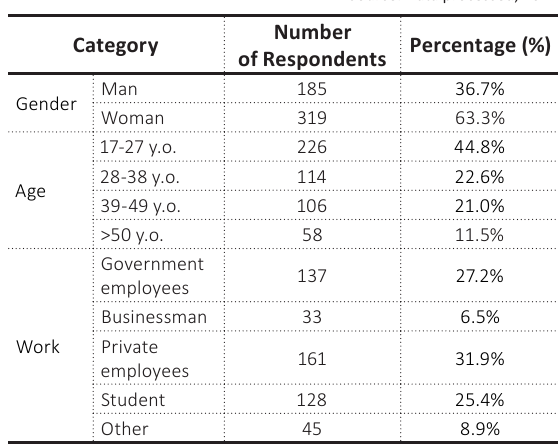
Table 1. Characteristics of